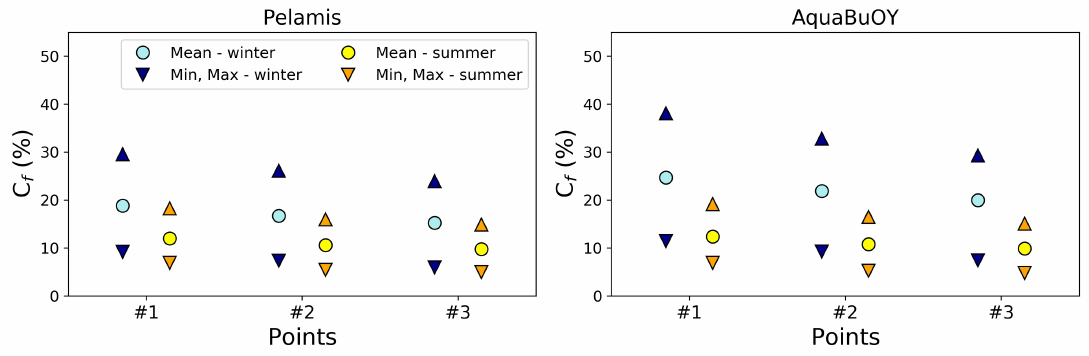
Figure 8. Mean, maximum and minimum monthly averaged capacity factors CF in winter (December–January–February) and summer (June–July–August) periods between 2004 and 2011 for Pelamis and AquaBuOY devices at three locations in offshore waters (between 50 and 70 m) of western Brittany (France) adapted from